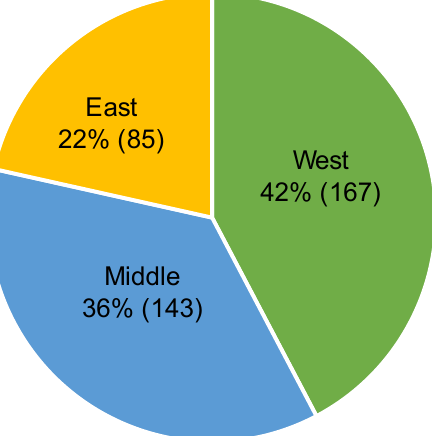
Figure A1. The distribution of sampling sites in the western, middle, and eastern parts of China. Numbers in the parentheses represent the sample size of regions. Eastern part: Fujian province (16), Jiangsu province (24), Zhejiang province (11), Hainan province (18), Shanghai (16). Middle part: Hubei province (42), Hunan province (19), Anhui province (32), Jiangxi province (50). Western part: Yunnan province (24), Sichuan province (17), Guizhou province (27), Chongqing (59), Tibet autonomous region (15), Guangxi autonomous region (25).